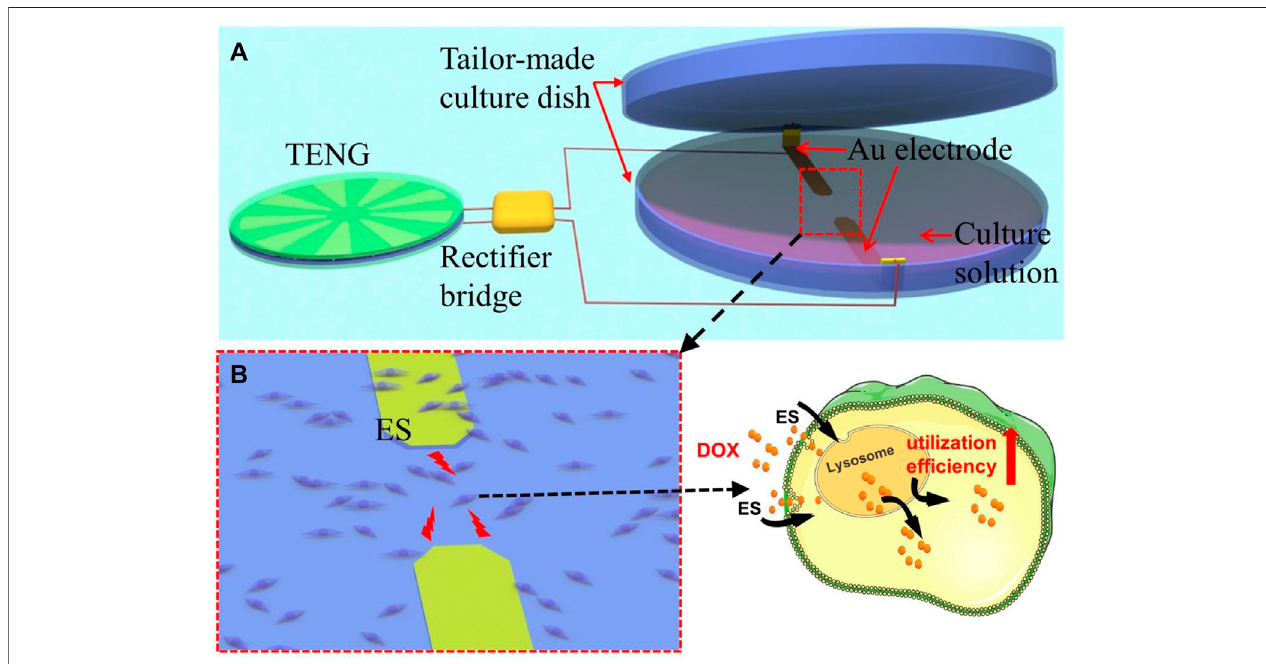
FIGURE 4 | In vitro self-powered drug delivery equipment. (A) Schematic diagram of the equipment. (B) Schematic diagram of the cells and Dox cocultured after electrical